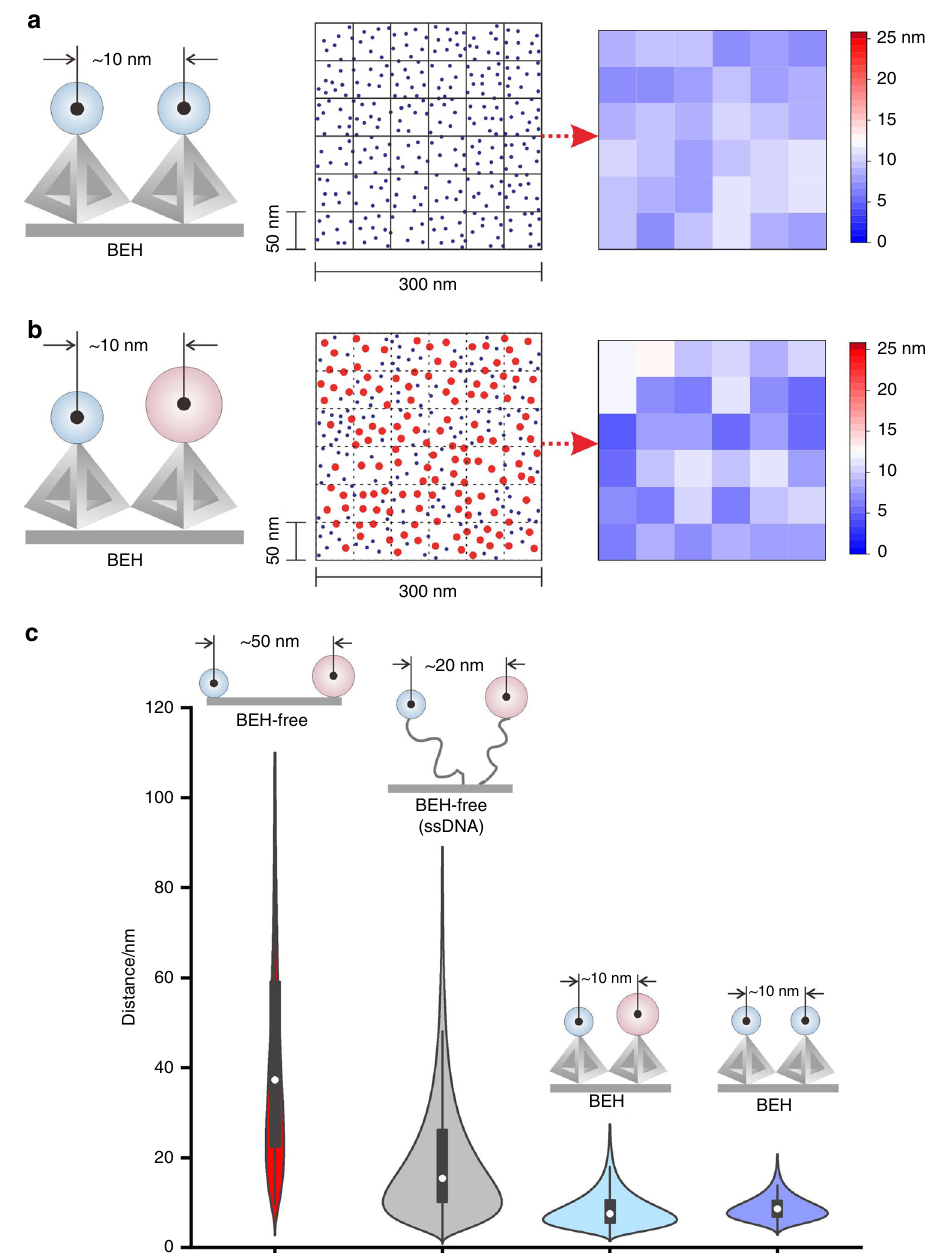
Fig. 2 Comparison of the inter-particle distance-controllability. a The scheme and the locations (blue dots) of the assembled AuNPs (5 nm in diameter) on gold surface (from SEM image) by using BEH strategy. We measured the inter-particle distance of a representative region with 300 × 300 nm, by dividing the region into a 6 × 6 matrix. The heatmap demonstrated the average inter-particle distance of each square (50 × 50 nm region) in the matrix. The average inter-particle distance for the whole area is 9.1 ± 2.8 nm. b The scheme and the locations (blue and red dots) of the assembled AuNPs (5 nm and 10 nm in diameter) on gold surface (from SEM image) by using BEH strategy. Red dots indicate AuNPs of 10 nm; Blue dots indicate AuNPs of 5 nm. The inter-particle distance of AuNP hetero-pairs was measured. The inter-particle distance obtained by the BEH strategy with TDN of 17 bp was ~8.5 ± 3.8 nm. c The distribution of inter-particle distance obtained with BEH and BEH-free strategies (naked gold surface and ssDNA modi fi ed surface). The inter-particle distance obtained by BEH-free strategies (~49.7 ± 25.6 nm for naked gold surface and ~19.3 ± 12.2 nm for ssDNA modi fi ed surface) were signi fi cantly larger than 10 nm. In the boxplots the white dots represent the median value, the up and down bounds of box represent the fi rst quartile and third quartile values and the vertical black line represent the whisker. The sample size used to derive statistics in c is 18, 118, 133, and 100, respectively. Source data are provided as a Source Data fi